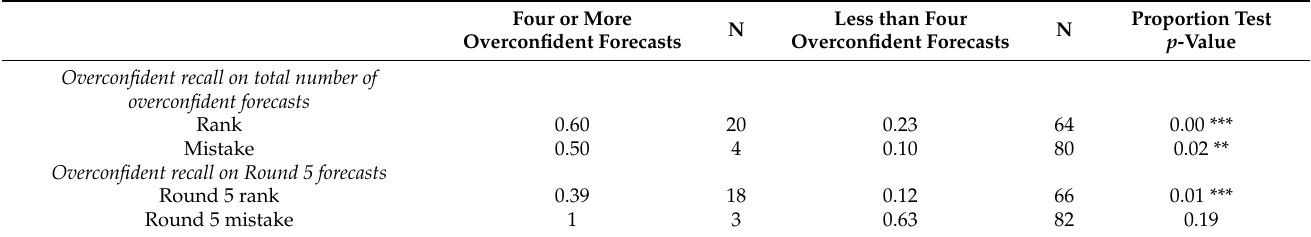
Table A2. Comparison of Overconfident Recall Conditional on Overconfidence in